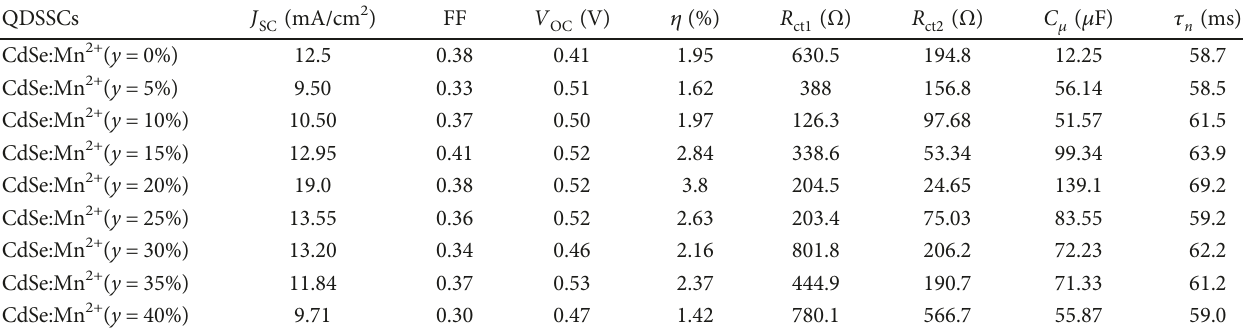
Table 4: The values of J - V curves and electrochemical impedance spectra with y from 0% to 40%.